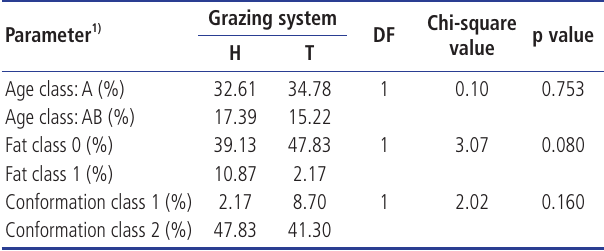
Table 7. Chi- square test of independence between grazing system and: age, fat and conformation